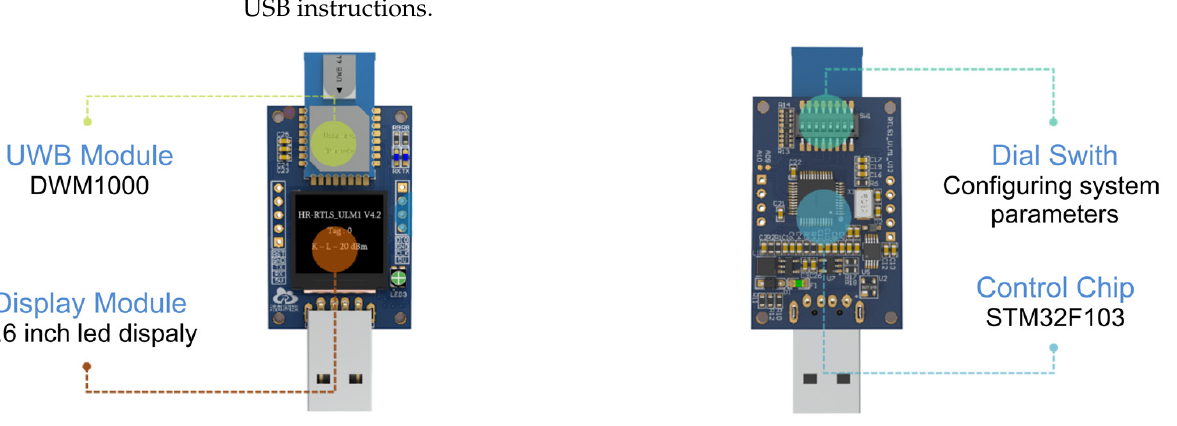
Figure 3. Experimental scene: ( a ) corridor; ( b ) connection of corridors.